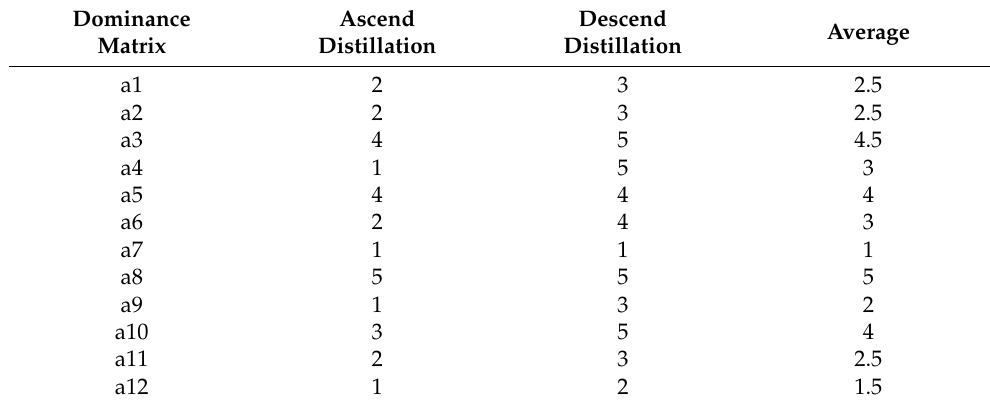
Table 7. Final ranking.